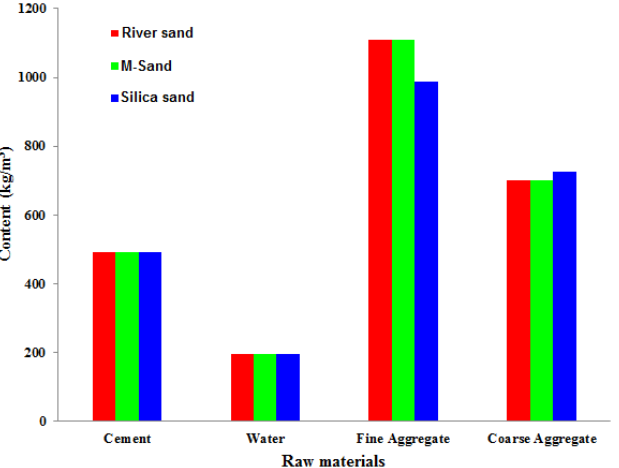
Figure 11. Mix Proportioning of M30 concrete with river sand, M Sand and silica